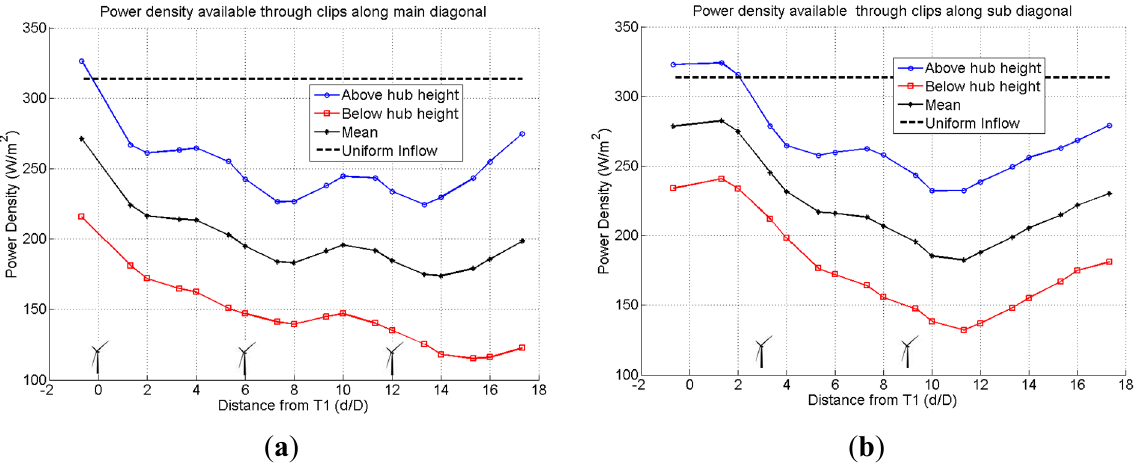
Figure 23. Power density across clipped wake surface cutting planes above/below hub height.